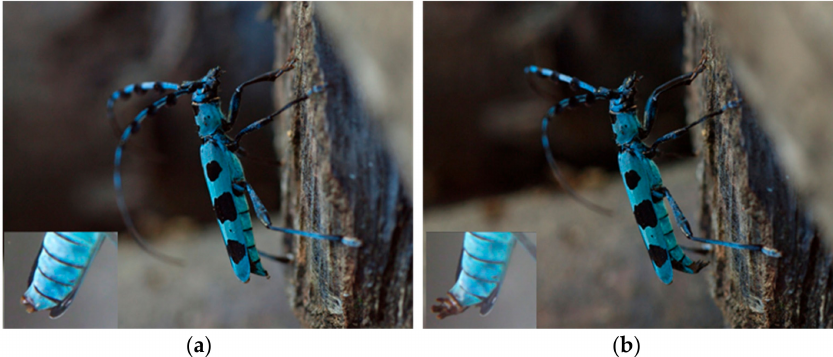
Figure 9. Two phases of Rosalia batesi male’s push-up stance. ( a ) Motionless phase, in which only the tip of the eighth tergite is visible; ( b ) Putative pheromone-emission phase, in which the male exposed the peculiar bifurcate abdominal tips, which he opened and closed in a rhythmic motion with 3–4 s intervals. The male switched between these two phases semi-periodically (photo by Takehiko